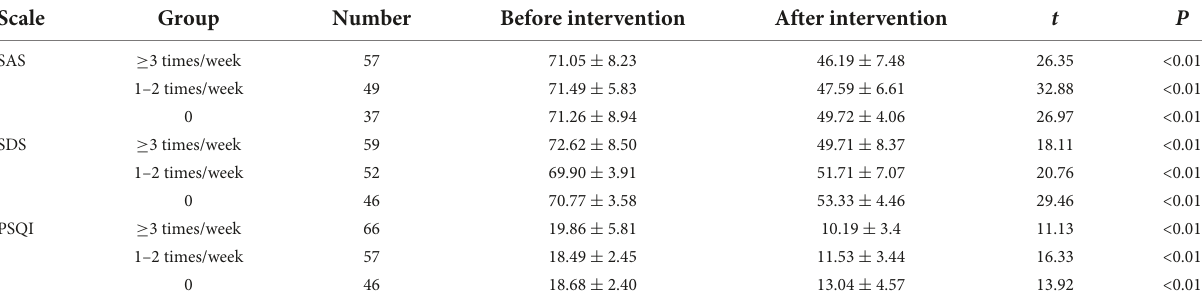
TABLE 4 Comparison of anxiety, depression and sleep of subjects under different exercise frequencies. Scale Group Number Before intervention After